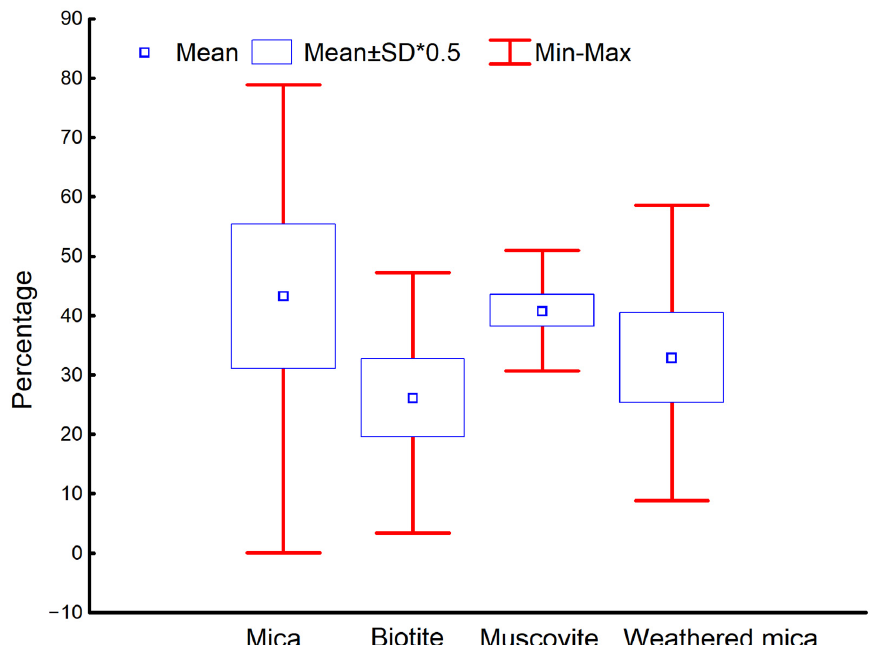
Figure 5. Mass percentage of mica and particle percentages of biotite, weathered mica and muscovite in the very fine sand fraction of Subei littoral plain area sediments (mass percentage of mica = 100 * total mica mass/total mineral mass. Particle percentage of biotite or weathered mica or muscovite = 100 * particle number of biotite or weathered mica or muscovite/total particle number of mica).